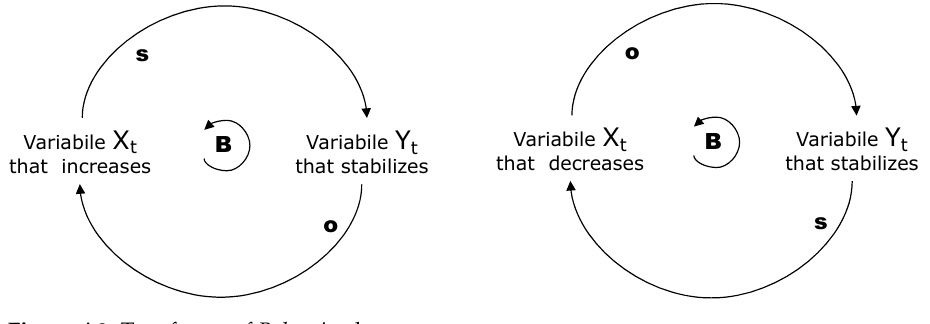
Figure A2. Two forms of Reinforcing loops. 2. Balancing loops ( B ), whose function is to maintain relatively stable the values of the linked variables, which are connected by a different direction of variation , i.e., “ s and o ”, or “ o and s ”, as in Figure A3.